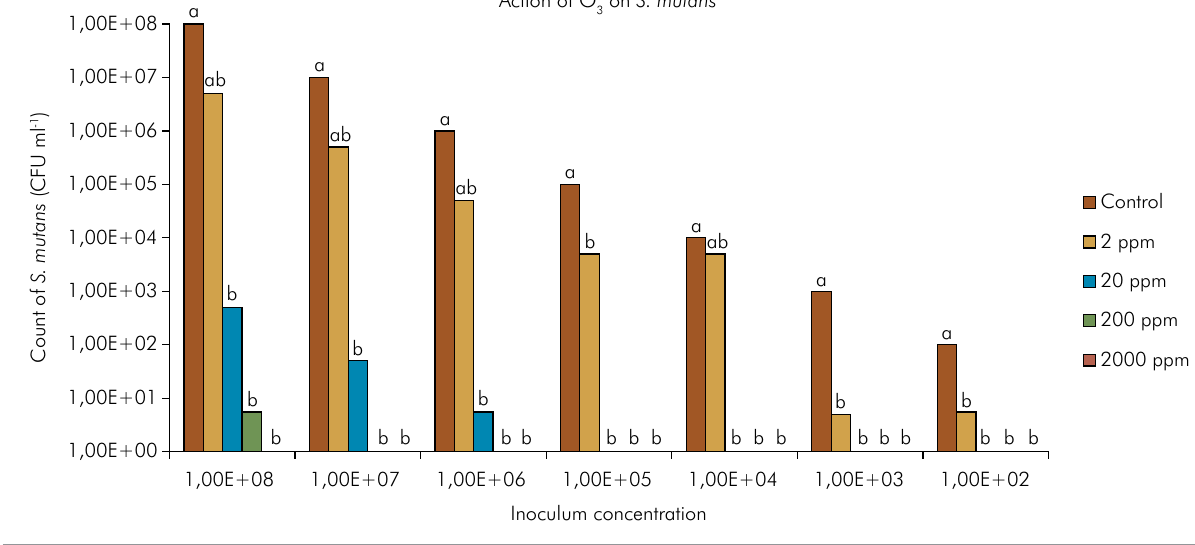
Figure 1. Inhibition of S. mutans growth in logarithmic scale (log10) after O lower case letters (for comparasions between O